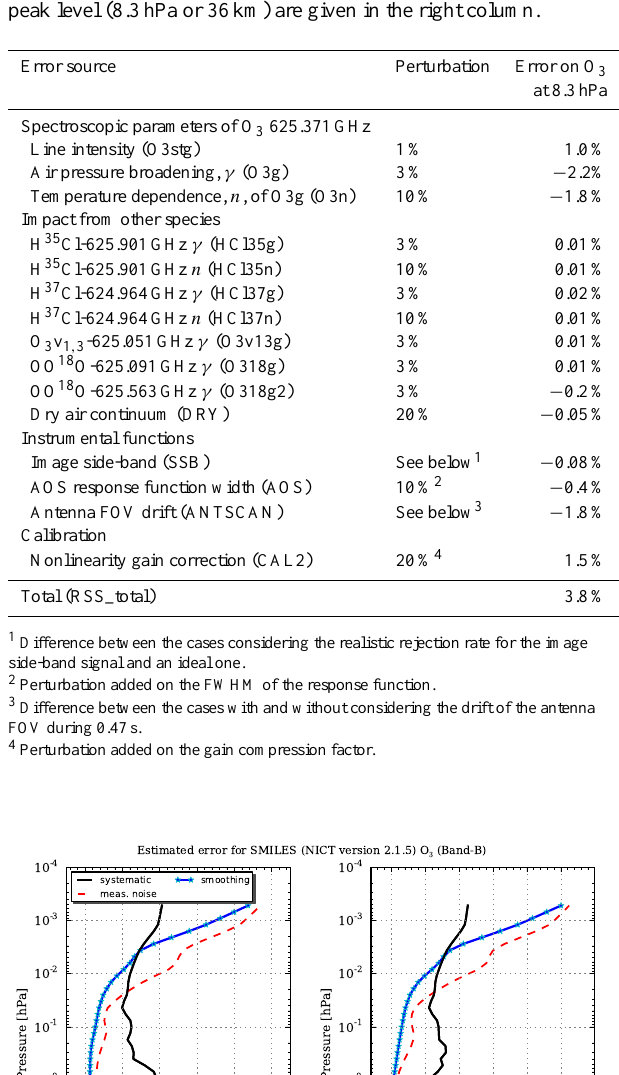
Table 3. Systematic errors and their perturbations considered in this study. For each error source, the corresponding label in Fig. 3 is indicated in the parentheses. The resulting error values at the O 3 peak level (8.3hPa or 36km) are given in the right column.